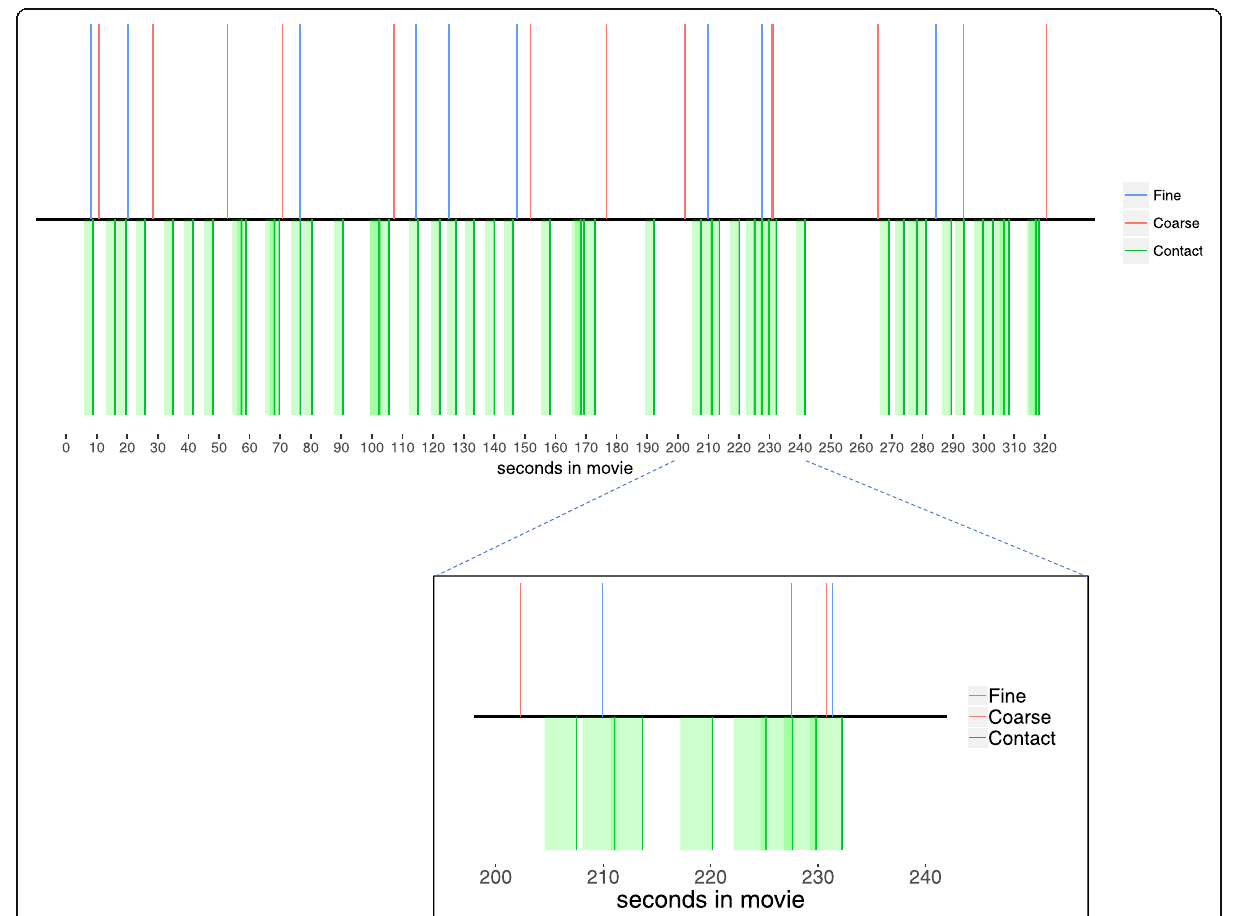
Fig. 2 The time course of one movie for a randomly chosen participant from Study 2. The x-axis displays the time in the movie in seconds. The blue and red lines depict fine and coarse boundaries, respectively. The dark green lines are the times of object contact. The light green shading depicts the 3000-ms interest period during which looking was measured. The inset zooms in on 40 s in the same movie to better show the relationships between event boundaries and object contacts. As is evident from this time course, it was possible for there to be multiple fine and course event boundaries during the three seconds before object contact. In addition, it was possible for there to be only fine, only coarse, or both fine and coarse boundaries within the three seconds before a given object